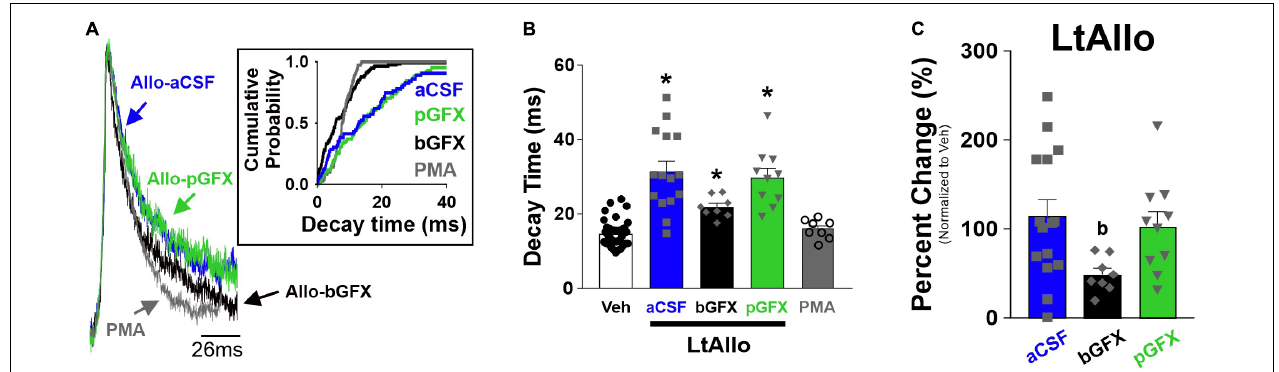
FIGURE 3 | Early protein kinase C (PKC) activation, but not constitutive PKC activity, is required for increased phasic GABA A receptor IPSC decay time during LtAllo. (A) Averaged trace of mIPSCs from DMV neurons after LtAllo (Allo-aCSF; blue trace), LtAllo with the PKC inhibitor Bisindolylmaleimide I co-applied in the bath (500 nM; Allo-bGFX; black trace), LtAllo with GFX restricted to the patch pipette (Allo-pGFX; green trace), and bath application of the PKC activator, phorbol 12-myristate 13-acetate in the absence of Allo application (PMA; 40 nM; gray trace). Averaged traces were normalized for amplitude. Inset graph shows mIPSC cumulative probability of decay time in a representative neuron during each treatment. (B) Mean ± SEM of mIPSCs decay time during Veh- and LtAllo-treated neurons (duplicated from Figure 1F ) during control conditions, Allo-bGFX (21.9 ± 1.0 ms; n = 8 from 3 mice), Allo-pGFX (29.79 ± 2.5 ms; n = 10 from 7 mice), and PMA (16.0 ± 0.8 ms; n = 8 from 6 mice). (C) Mean ± SEM of mIPSC decay time relative change (from Veh-treatment group) in Allo-aCSF (114.2 ± 18.8%; n = 15 from 9 mice), Allo-bGFX (48.9 ± 6.9%; n = 8 from 3 mice), and Allo-pGFX (102.7 ± 17.0%; n = 10 from 7 mice). One-way ANOVA with Tukey’s post hoc , * indicates significant differences from Veh; (b) indicates significant difference from Allo-aCSF. Significance indicates p ≤